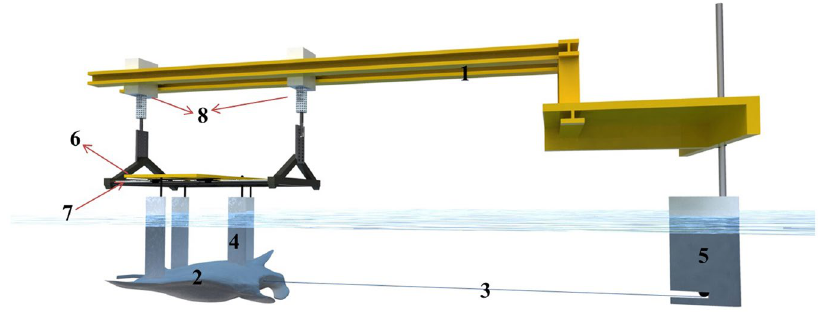
Figure 9. Schematic diagram of the towing test: 1. Carriage; 2. Manta ray model; 3. Rag force line; 4. Tear- shaped columns; 5. Front tear-shaped column; 6. Longitudinal motion support; 7. Longitudinal guide rod; 8.